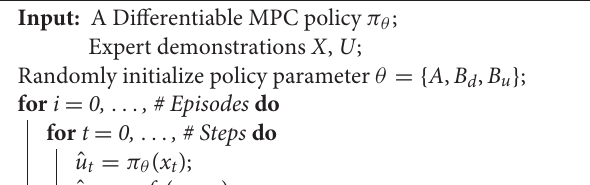
Algorithm 1: Offline Pre-training—Imitation Learning.